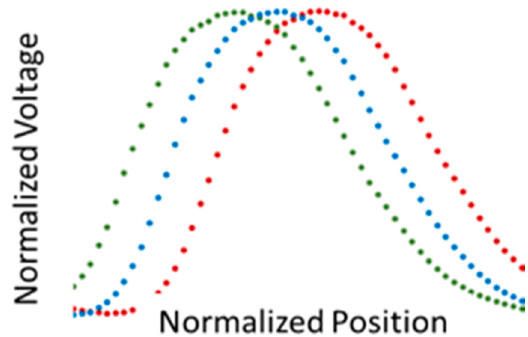
Figure 11. Calculated quasi-Gaussians for a target located − 2 (green), 0 (blue), and 2 cm (red) displacement from the centerline of the sensor.